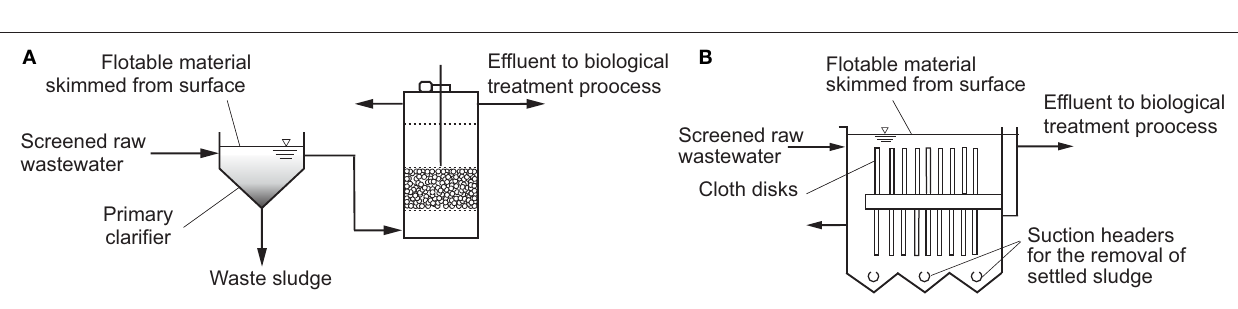
FIGURE 3 | Definition sketch for (A) primary effluent filtration (PEF) and (B) primary filtration (PF) with cloth disc filter. In both cases, floatable material and heavier settleable solids are removed